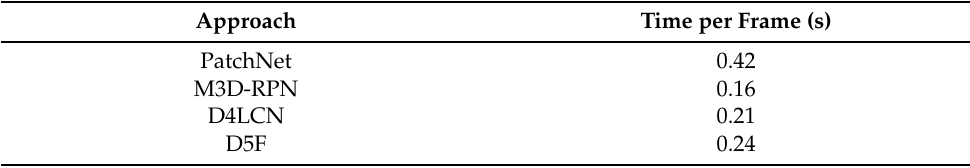
Table 9. Inference time per frame of compared